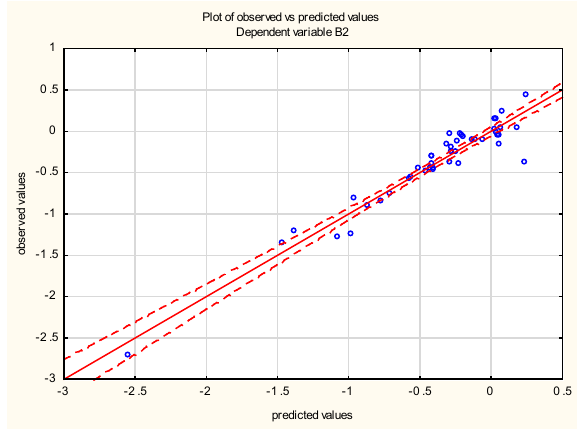
Figure 2: Plot of observed vs. predicted values. Dependent variable B2. Plot of observed vs. predicted values Dependent variable B2